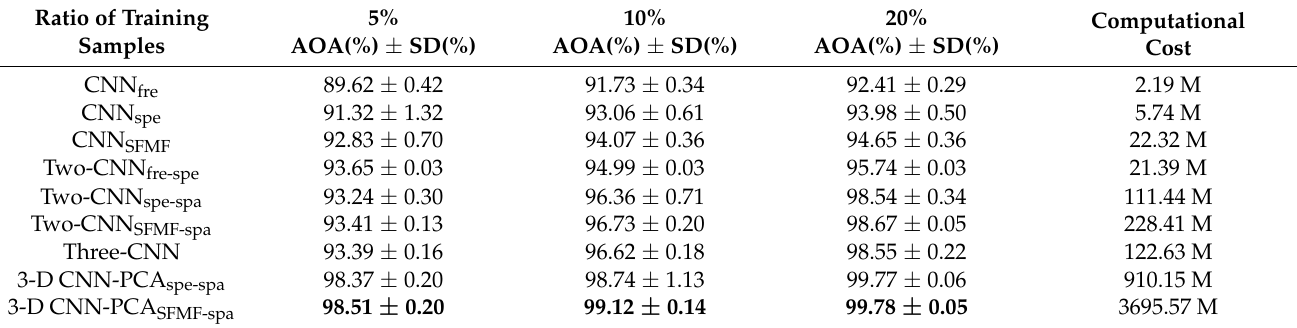
Table 2. Classification results of Pavia University